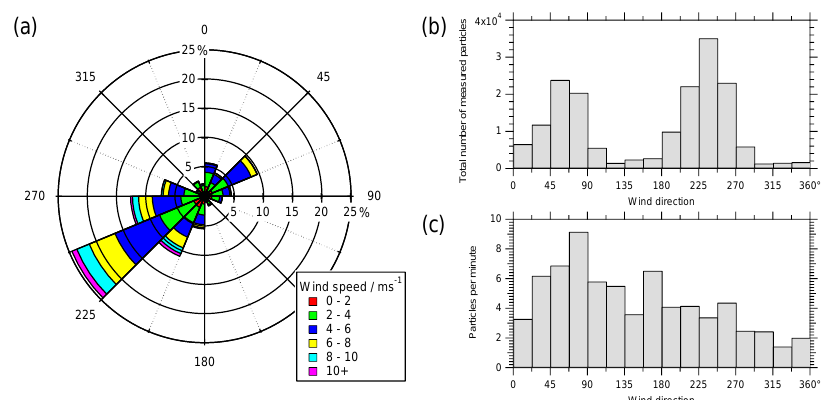
Figure 4. (a) Wind rose showing wind speed and direction for the whole time period. (b) Absolute number of analysed particles per wind direction. (c) Same as (b) but normalised to the measurement time per wind direction.